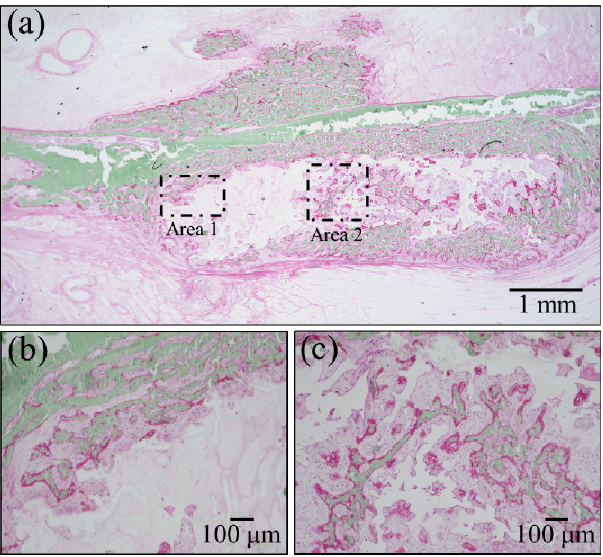
Figure 7. Results of Villanueva–Goldner staining: ( a ) low-resolution histological image of the regenerated bone treated with the NanoCliP-FD scaffold; enlargements of the square insets are shown in ( b ) and ( c ) for Area 1 and Area 2, respectively; mature and immature bone in green and violet, respectively.